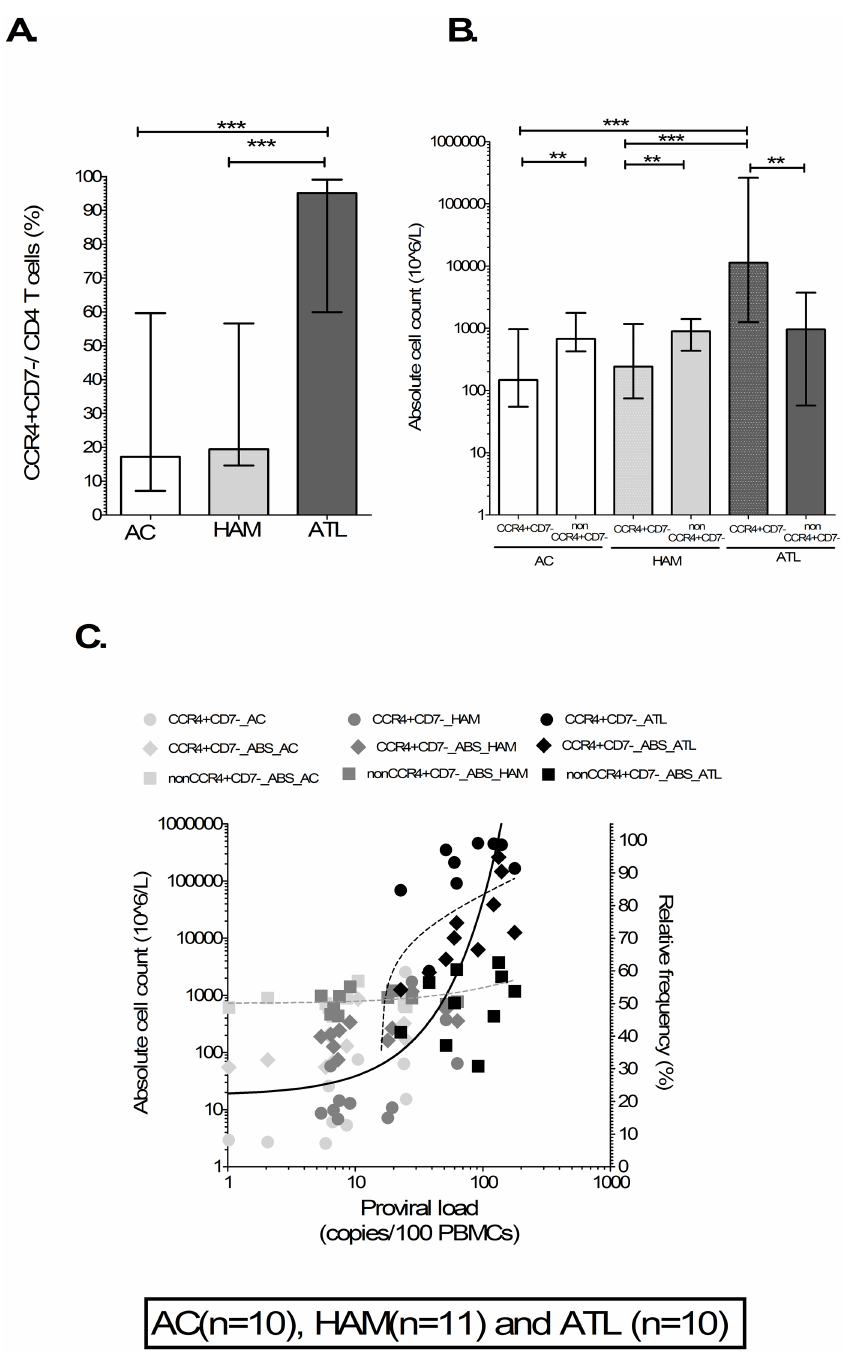
Fig 5. CD4+CCR4+CD7- T cells as marker of ‘ATL-like’ infected and ATL cells. Bar column plots showing the absolute frequency and relative of CD4+CCR4+CD7- (A & B) and non CCR4+CD7- CD4+T cells in AC, patients with HAM and ATL showed highly significant increased frequency of CD4+CCR4+CD7- T cells in patients with ATL compared to AC and HAM. The bar represents median values. Statistical analysis: Kruskal-Wallis test with Dunn post- test, 95% confidence interval and Wilcoxon signed rank test. C) XY scatters plots showing significant positive correlation of PVL with relative and absolute frequency of CD4+CCR4+CD7- T cells. The line represents linear regression line with rho and R for Spearman and linear regression correlate respectively. (cid:3) denotes p < 0.05, (cid:3)(cid:3) denotes p < 0.01, (cid:3)(cid:3)(cid:3) denotes p < 0.001.